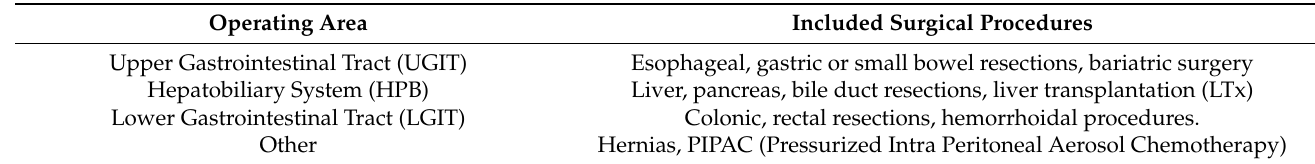
Table 2. Classification of surgical interventions into four